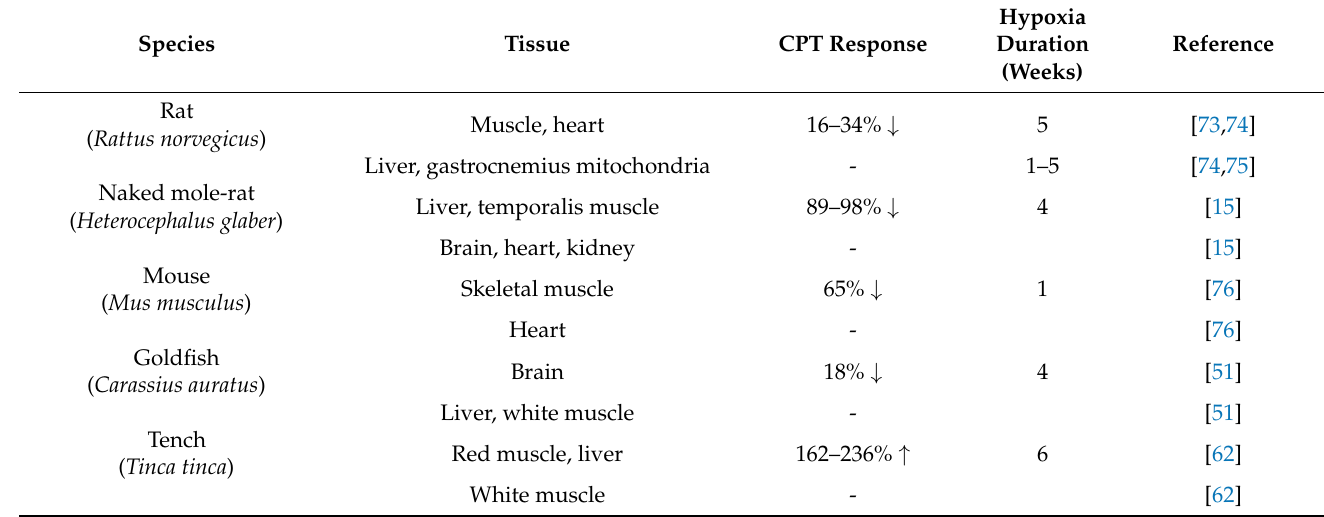
Table 6. Effects of chronic hypoxia (minimum 1 week) on the maximal activity of carnitine palmitoyl transferase (CPT) in various